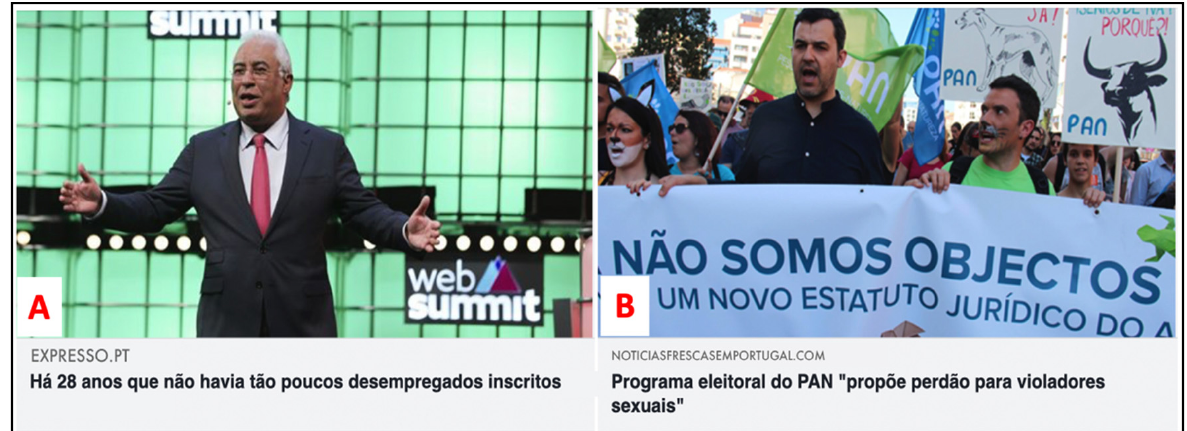
Figure 2. Presentation of news ( A ) and fake news ( B ) on Facebook. Note: The fake news format presented was adapted from the Portuguese fact-checking website, Polígrafo. Available on: https://bit.ly/3b8TzXz (accessed on 3 March 2022).